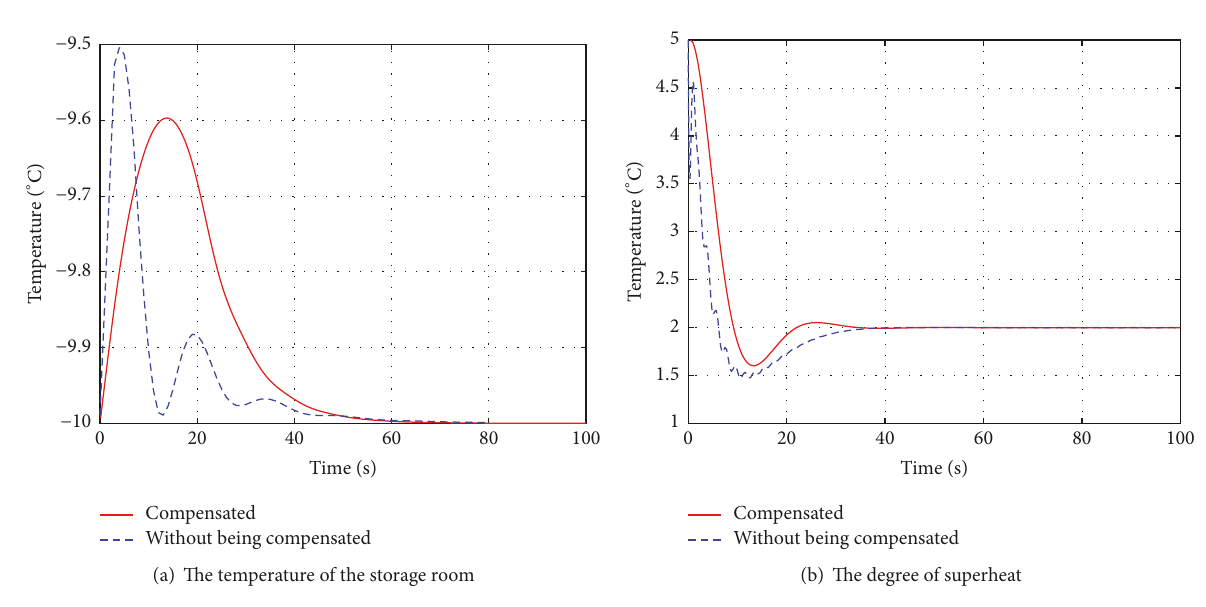
Figure 5: Response curves when the degree of superheat